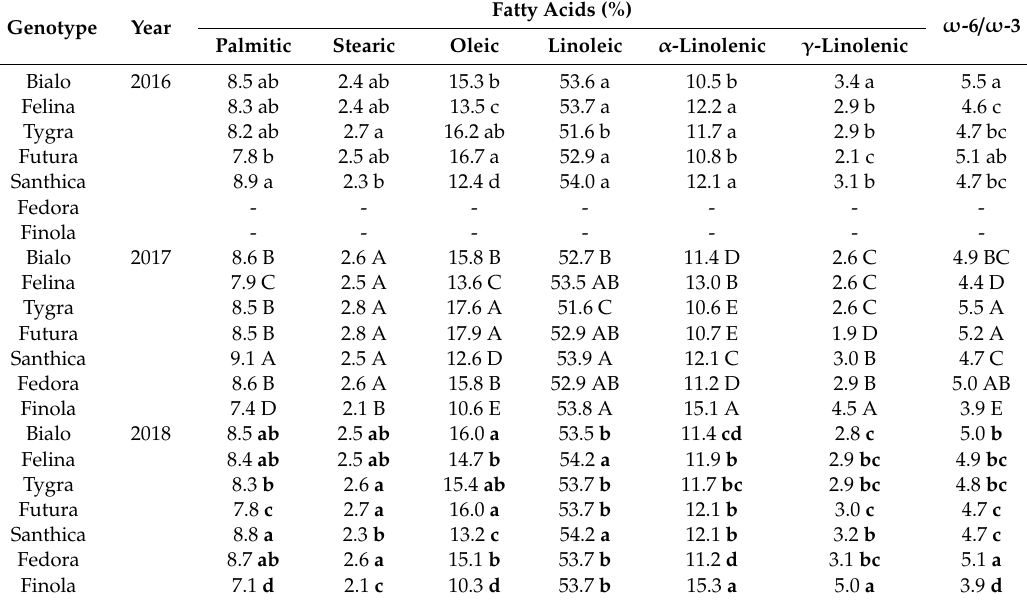
Table 4. Fatty acid composition of hemp seeds from the seven industrial hemp cultivars cultivated in this study and for three growing seasons (2016, 2017, and